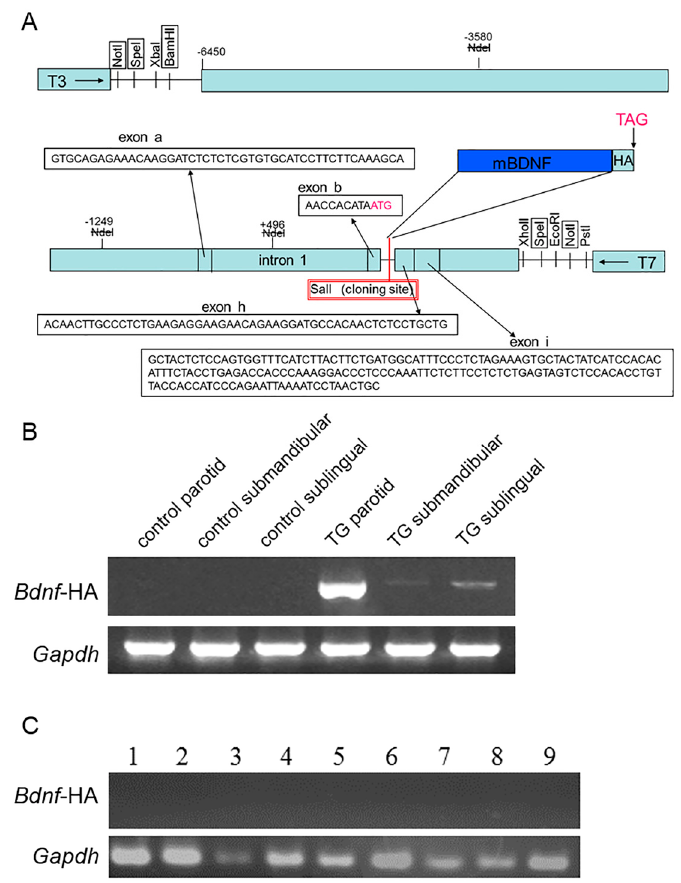
Figure 1. Transgene construct and expression. ( A ) To direct brain-derived neurotrophic factor (BDNF) expression to the salivary glands, mouse Bdnf cDNA was linked to the mouse parotid-specific protein promoter. In addition, the construct was linked to a hemagglutinin (HA) tag to distinguish it from endogenous BDNF; ( B ) Transgenic mice (TG) showed markedly elevated Bdnf -HA mRNA expression in the parotid gland compared with C57BL/6 control mice; ( C ) In generated transgenic (TG) mice, a number of tissues (excluding the salivary glands) do not express the Bdnf -HA gene. 1: cerebral cortex; 2: hippocampus; 3: pituitary gland; 4: spleen; 5: liver; 6: adrenal gland; 7: lung; 8: kidney; 9: heart. Mouse glyceraldehyde-3-phosphate dehydrogenase ( Gapdh ) gene expression was observed in all samples.